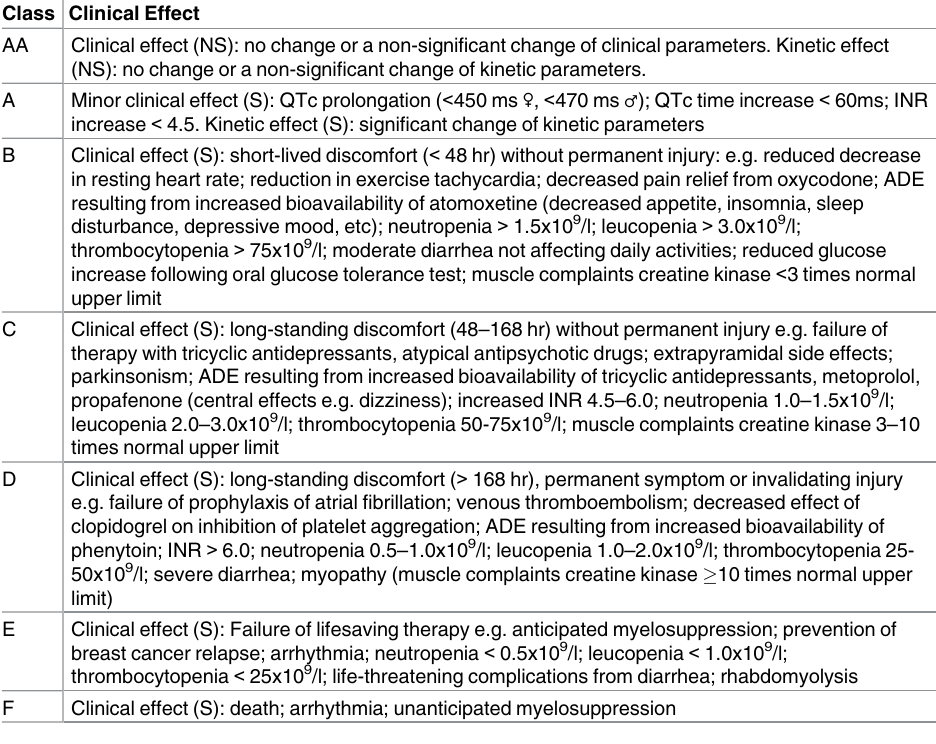
Table 2. Classification of potential clinical effects observed in patients with risk phenotypes, based on DPWG